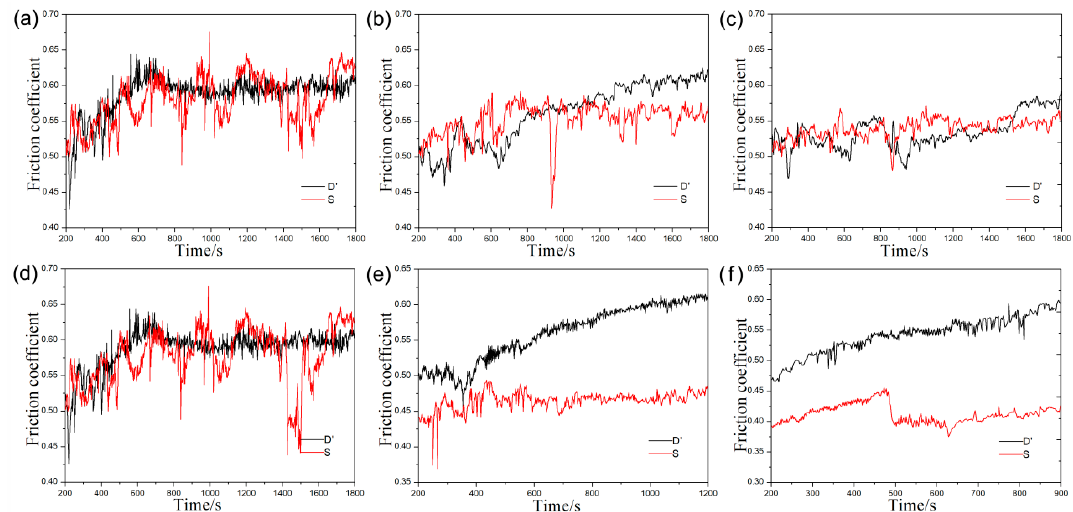
Figure 10. Friction-coefficient curves of the ductile iron and carbon steel wheels under different normal loads at different sliding velocities: ( a ) 50 N, ( b ) 60 N, ( c ) 70 N, ( d ) 6.3 × 10 4 mm/min, ( e ) 9.42 × 10 4 mm/min, and ( f ) 12.54 × 10 4 mm/min.